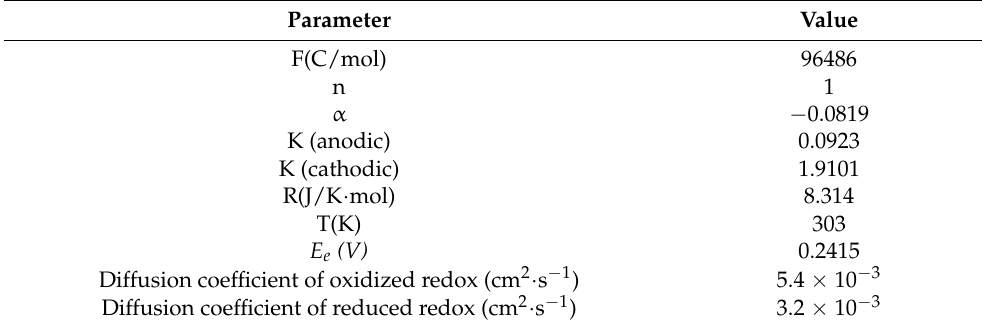
Figure 11. Plot of ( left ) cathodic and ( right ) anodic voltage versus log of scan rate for the imprinted polymer. Table 8. Parameter values for determination of heterogeneous electron transfer rate constant, 𝑘 d.